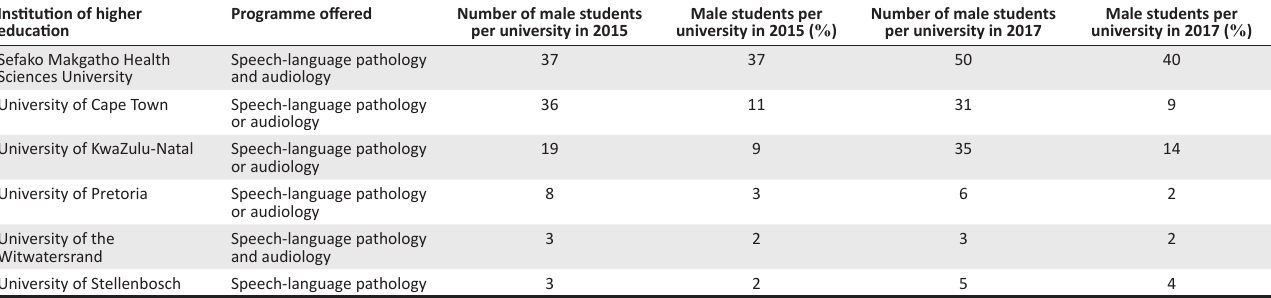
TABLE 1: Demographic information of all male undergraduate students of all year levels registered at various institutions of higher education in South Africa for speech-language pathology and audiology in 2015 and 2017. Institution of higher